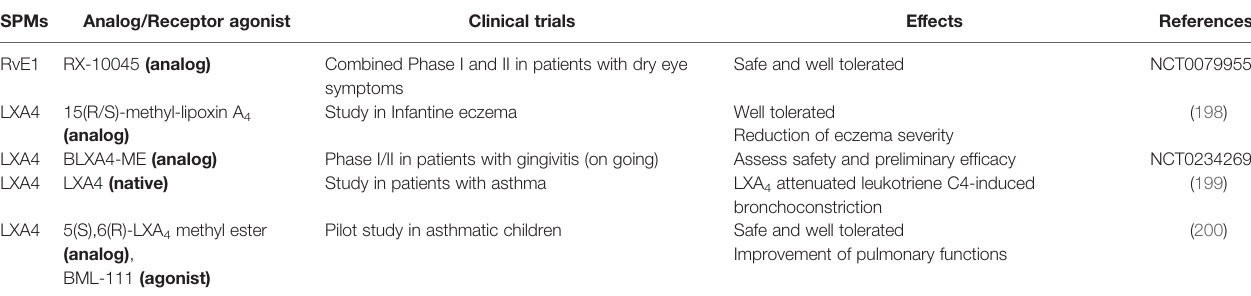
TABLE 6 | SPMs and SPM mimetics tested in